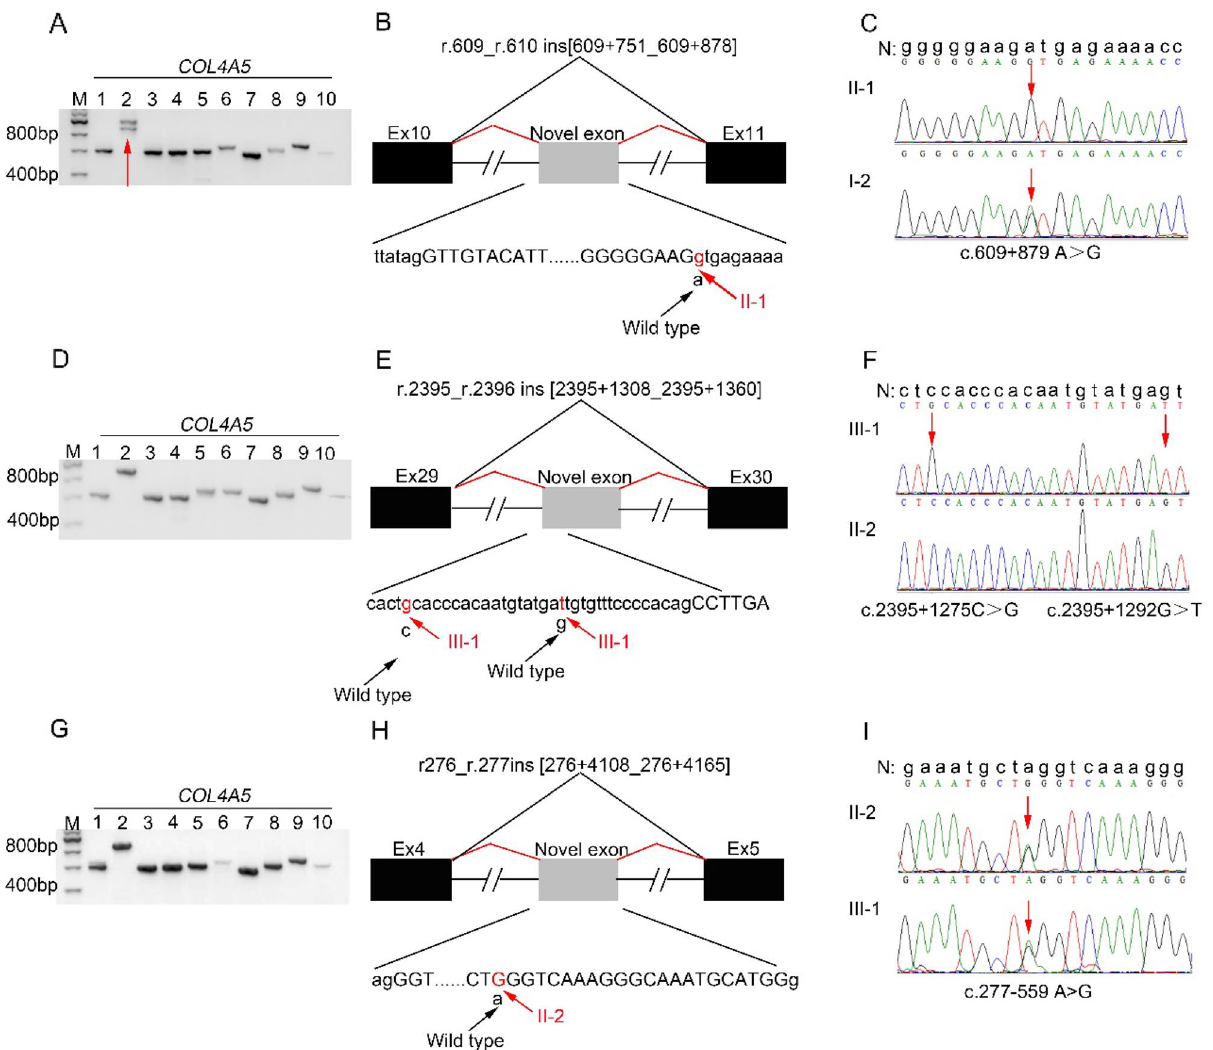
Figure 5. COL4A5 gene analysis in probands 3–5 (II-1 of family 3, III-1 of family 4, and II-2 of family 5). ( A , D , and G ) Agarose gel images of RT-PCR products for skin fibroblasts of probands 3–5 (II-1 of family 3, III-1 of family 4, and II-2 of family 5), respectively. M: DNA molecular mass marker. Lane 1 to 10: 10 overlapping PCR products covering the entire COL4A5 cDNA from probands 3–5 (II-1 of family 3, III-1 of family 4, and II-2 of family 5). The red arrow indicates an abnormal transcript in addition to the wild-type transcript. ( B , E , and H ) Schematic representation of the aberrant COL4A5 cDNA caused by the deep intronic splice variants detected in probands 3–5 (II-1 of family 3, III-1 of family 4, and II-2 of family 5), respectively. Exons are represented by black filled rectangles and are numbered, and the novel exon is indicated by the gray filled rectangle. Capital and lowercase letters are used to depict exon and intron sequences, respectively. The black and red lines indicate wild-type and abnormal splicing, respectively. The black arrows indicate the wild-type nucleotide, and the red arrows showed the changed nucleotide. ( C ), ( F ), and ( I ): sequencing of PCR amplified products containing the deep intronic variants for families 3–5, respectively. N, wild type sequence. Intron sequences are depicted by lowercase letters. The red arrows indicate the changed